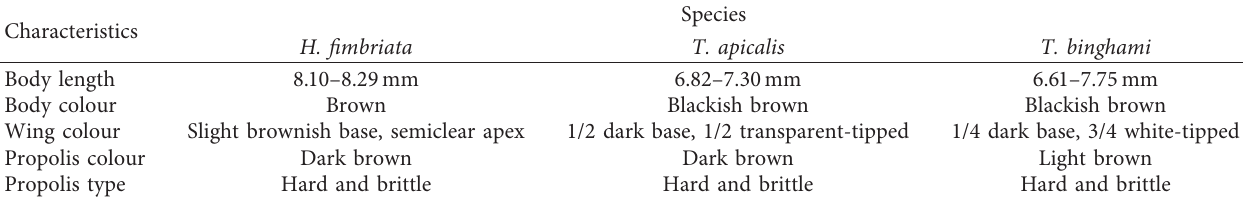
Table 1: General physical characteristics and propolis attributes of H. fimbriata , T. apicalis , and T. binghami .